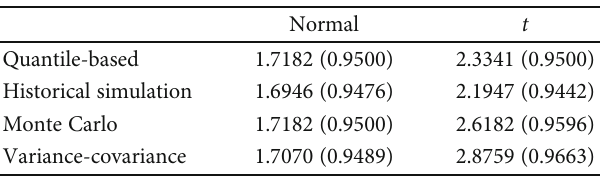
Figure 1: VaR forecast of normal distribution (a – d) and t distribution (e – h) calculated from the distribution function; the red dot mark in the fi gure shows the “ position ” of the VaR forecast (to x -axis) and its corresponding ( 1 − α ) (to y -axis). Table 1: The estimative VaR forecast and its coverage probability (in the bracket) of a random